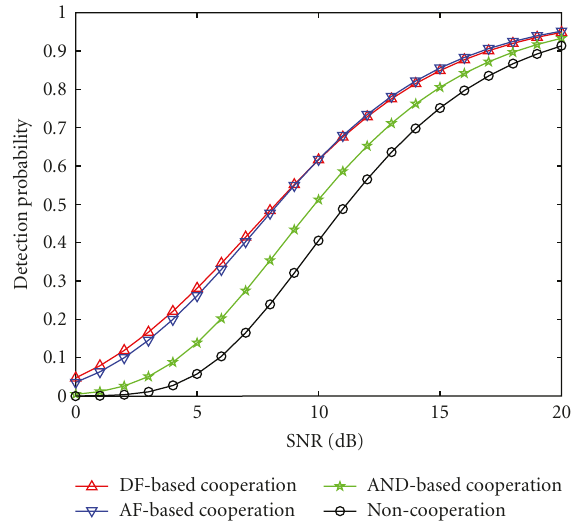
Figure 2: Detection probability performance versus T-SNR γ s with α = 0 . 01, σ 2 p 1 = 1 and η = μ = 10dB, where η = 20log ( σ 21 /σ p 1 ). and μ = 20log 10